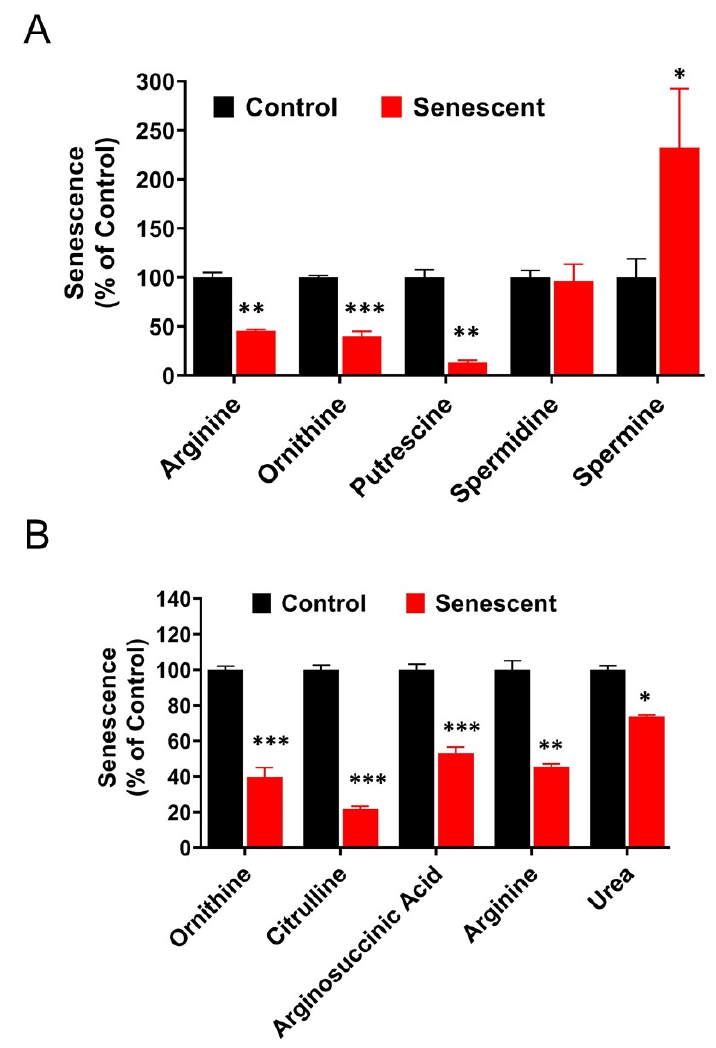
Figure 10. Levels of Polyamine and Urea metabolites in control and senescent HCT-116 cells. ( A ) Polyamine metabolites in control and senescent HCT-116 cells. ( B ) Urea cycle metabolites in control and senescent HCT116 cells. Metabolites in senescent cells are expressed as percent of control based on protein concentration of samples. Actual values obtained from analysis (nmoles/g protein) including p values and significance is presented in Table S2. * p < 0.05, ** p < 0.01, *** p <